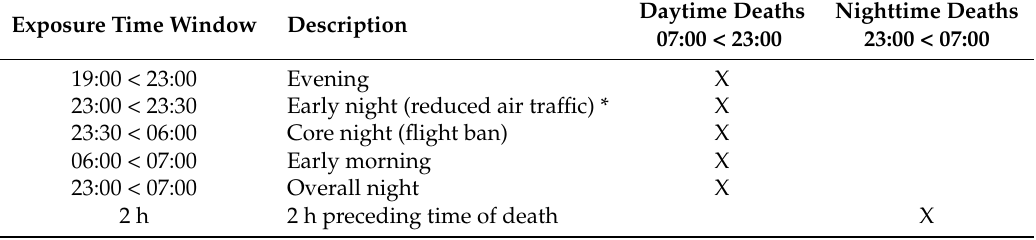
Table 1. List of the five different nighttime exposure windows considered for death case events occurring during the day and the night